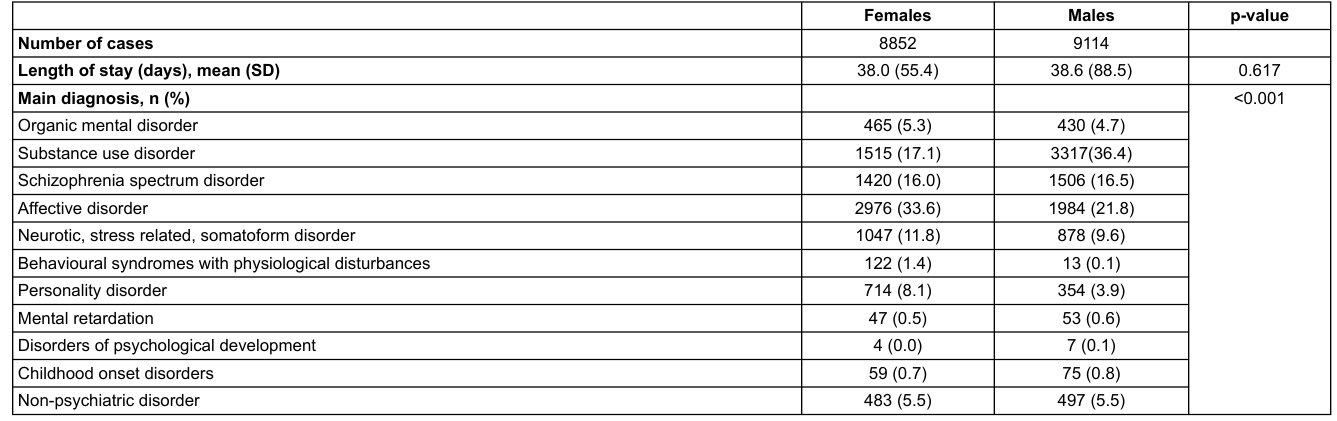
Table 2: Clinical patient